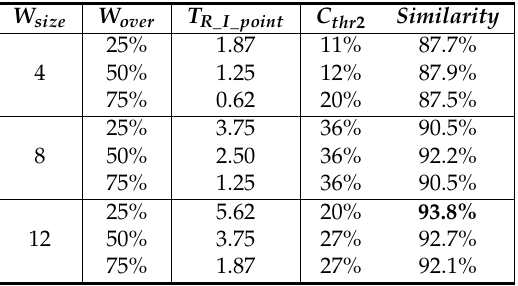
Table 3. Quantification results obtained from analyzing a video sequence for all windowing parameter combinations. Bold data indicates the highest score obtained for each